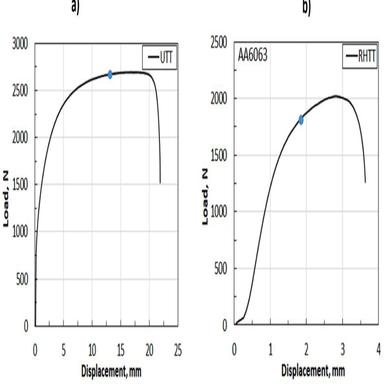
Experimental load–displacement curves for: a) the UTT and b) the RHTT.